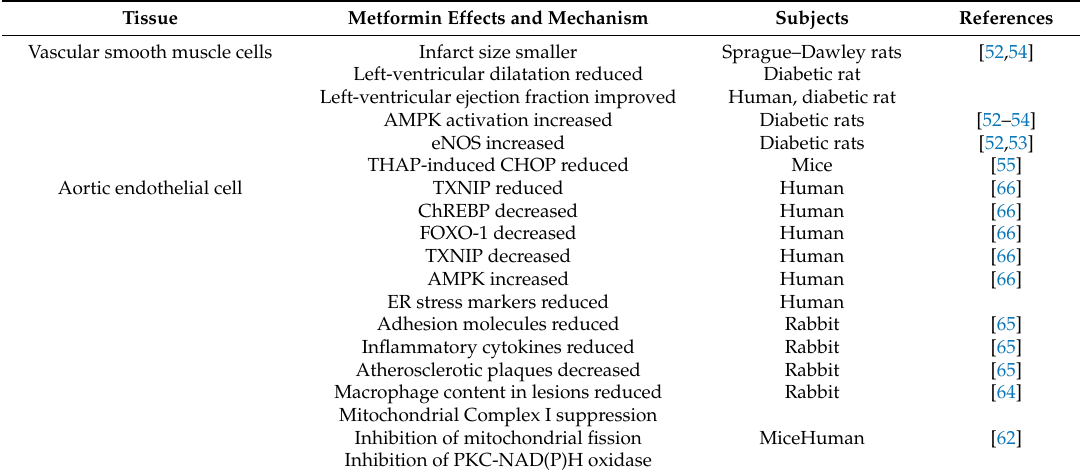
Table 4. Cardiovascular protective effect of